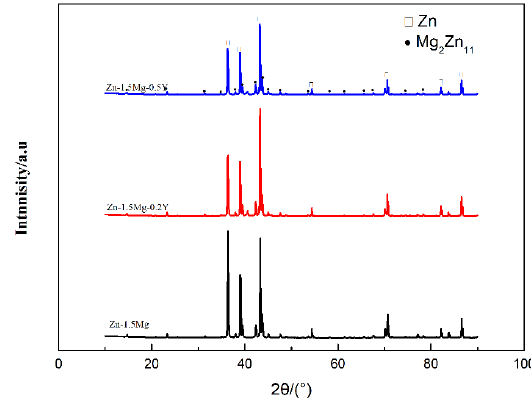
Figure 1. The XRD patterns of Zn-1.5Mg-xY alloys.